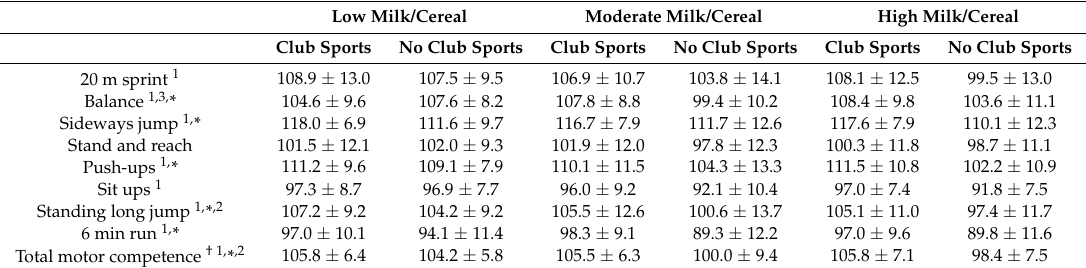
Table 3. Motor competence by milk/veggie consumption and sports participation. Values are sex-and age-normalized Means † ± SD.